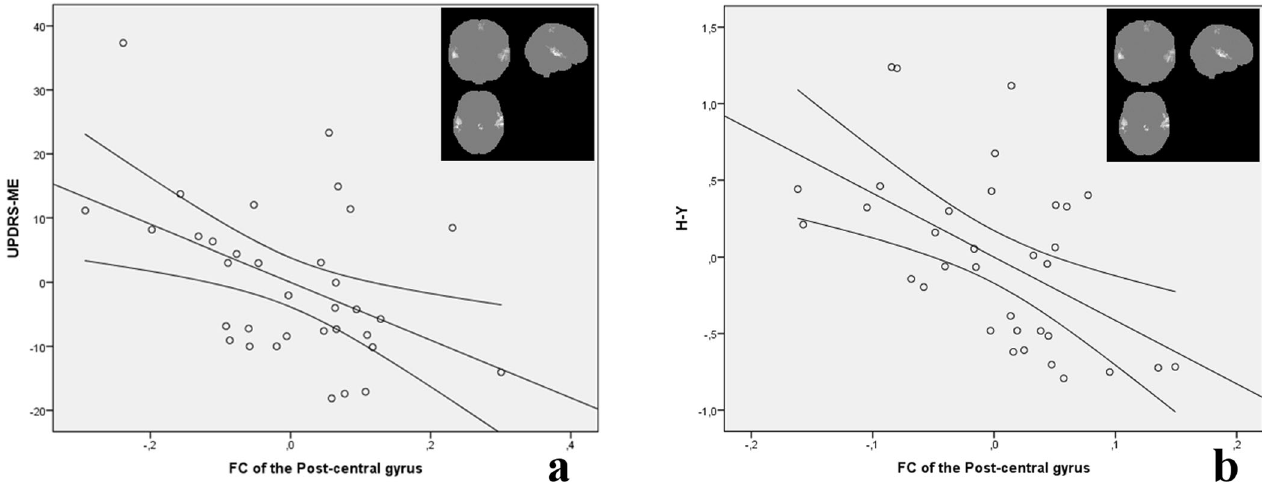
Fig. 5 Correlations of post-central cortex FC with clinical scores. Scatterplots of the Uni fi ed Parkinson ’ s Disease Rating Scale Motor Examination score (UPDRS-ME, a , p = 0.007) and Hoehn and Yahr stage (H&Y, b , p = 0.002) against the mean FC of the regions where the post- central cortex FC correlates with pPDU (highlighted in the inserts on the right, the most affected side is at reader ’ s left). For each graph, residuals from the linear regression analysis, following correction for age sex and motion parameters, are plotted. Regression line along with the 95% con fi dence intervals is